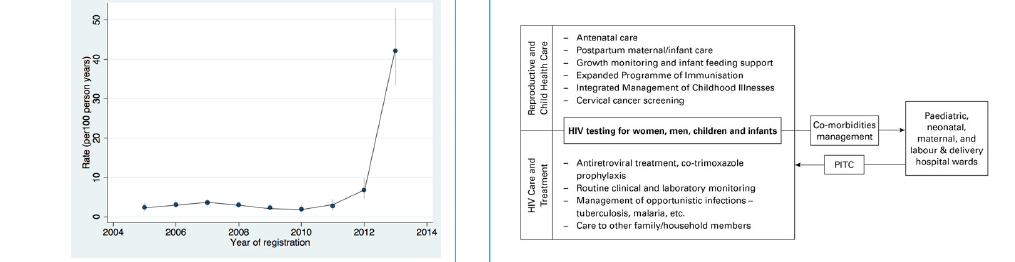
Figure 4: The One Stop Clinic of Ifakara integrates health services for HIV-infected children, pregnant women, HIV-exposed infants and their families (adapted from [27]). HIV = human immunodefi- ciency virus; PITC = Provider Initiated Testing and